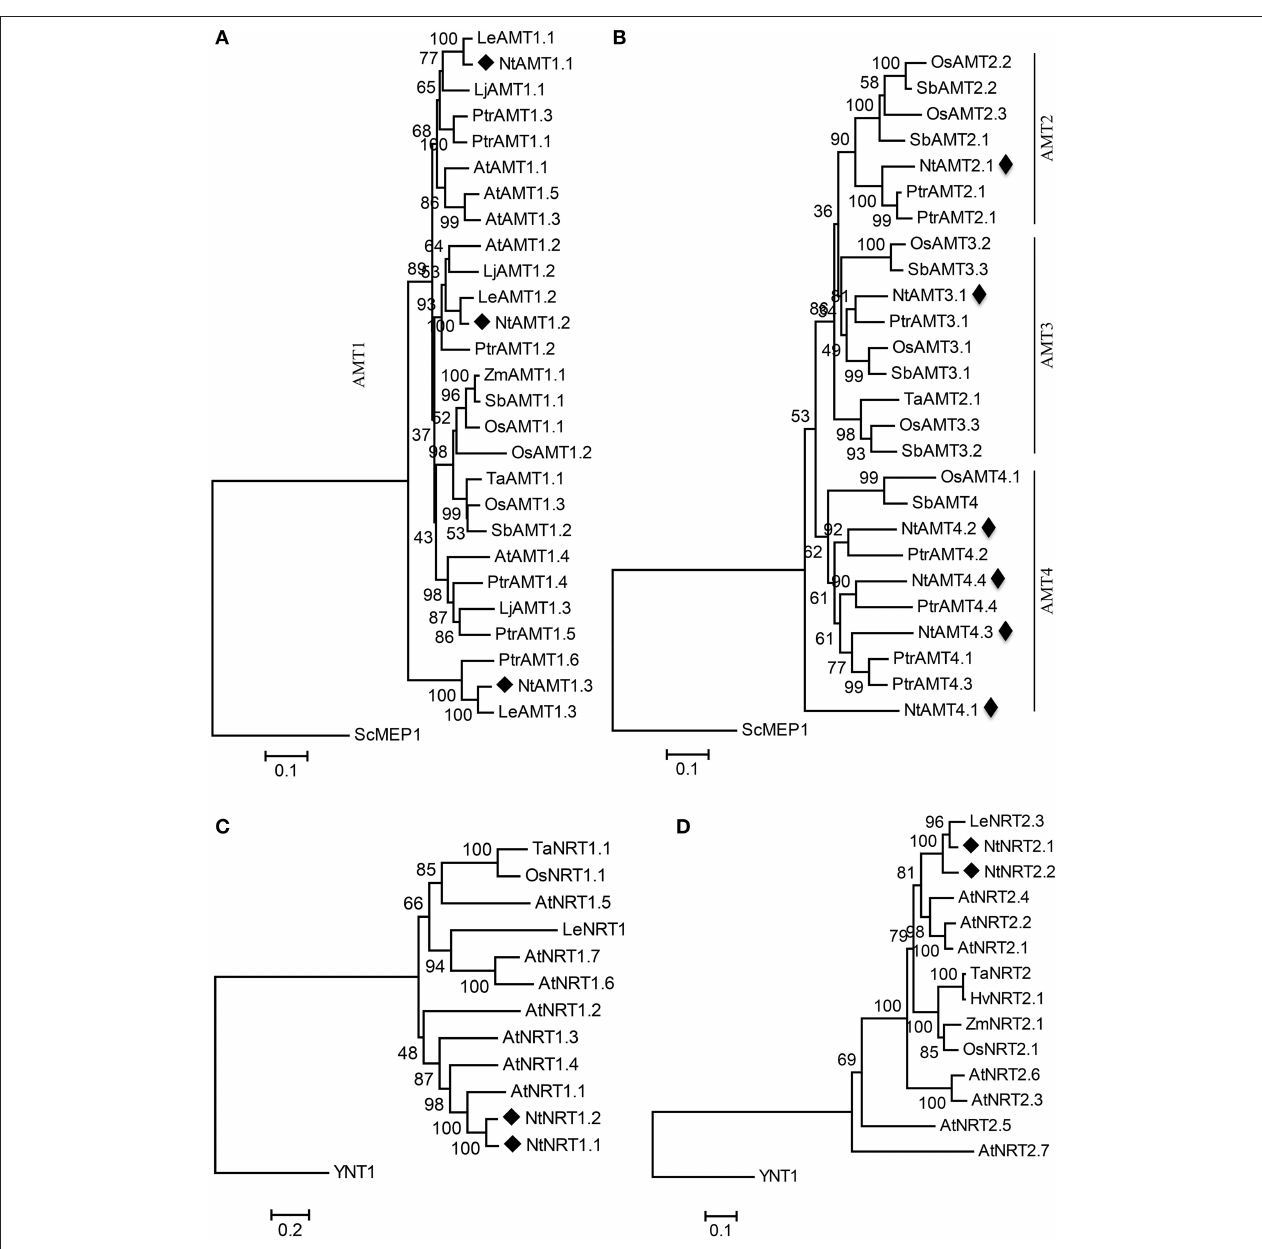
FIGURE 1 | Phylogenetic tree of putative tobacco AMTs (A,B) and NRTs (C,D) with their representative counterparts from other plant species. The trees of AMT1 (A) and AMT2, 3, 4 (B) subclades were rooted using a Saccharomyces cerevisiae ScMEP1 sequence as an outgroup. Likewise, Hansenula polymorpha YNT1 protein was picked as an outgroup for NRT1 (C) and NRT2 (D) subcluster. Phylogenetic analysis was performed using the Neighbor-Joining method from MEGA6. Bootstrap values are from 1,000 replications. Evolutionary distances were estimated in a unit of the number of amino acid substitutions per site, with a scale bar equivalent to